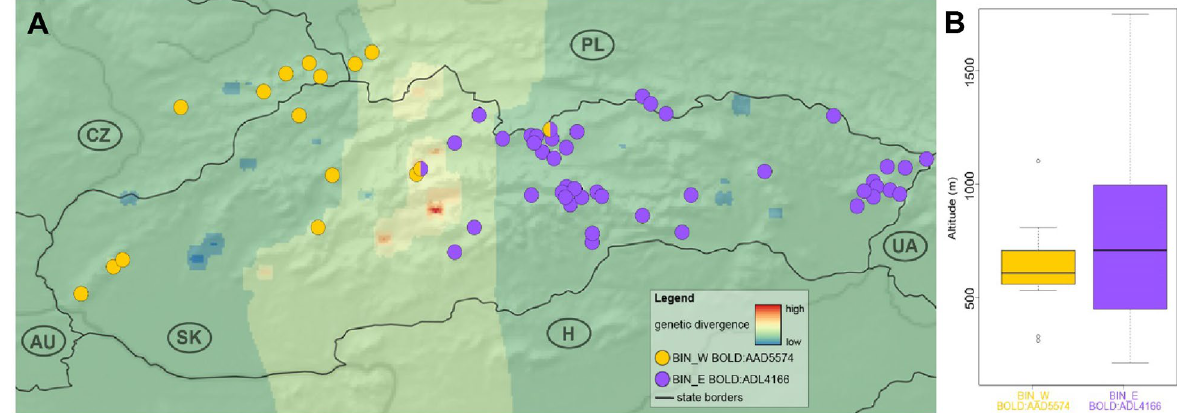
Figure 2. The distribution of the R. tristis BINs, their genetic divergence and elevation range within the studied area. ( A ) The genetic landscape map of the studied area based on 5 ′ COI mtDNA haplotypes with the distribution of two different BINs (BIN_W—yellow, BIN_E—violet). Abbreviations: Slovakia (SK), Hungary (H), Ukraine (UA), Poland (PL), Czech Republic (CZ) and Austria (AU). The map generated in QGIS 3.16 (https:// qgis. org/); ( B ) The elevation range of both BINs. The boxplots show the distribution of the elevation above sea level for BIN_W and BIN_E. The boxes represent the interquartile distances (IQD), while the central lines through each box show the medians. The dots indicate outliers and the whiskers extend to the extreme values of the data, calculated as ± 1.5 × IQD from the median. Wilcoxon signed-rank test supported the significant differences in elevation range between two BINs (p-value <